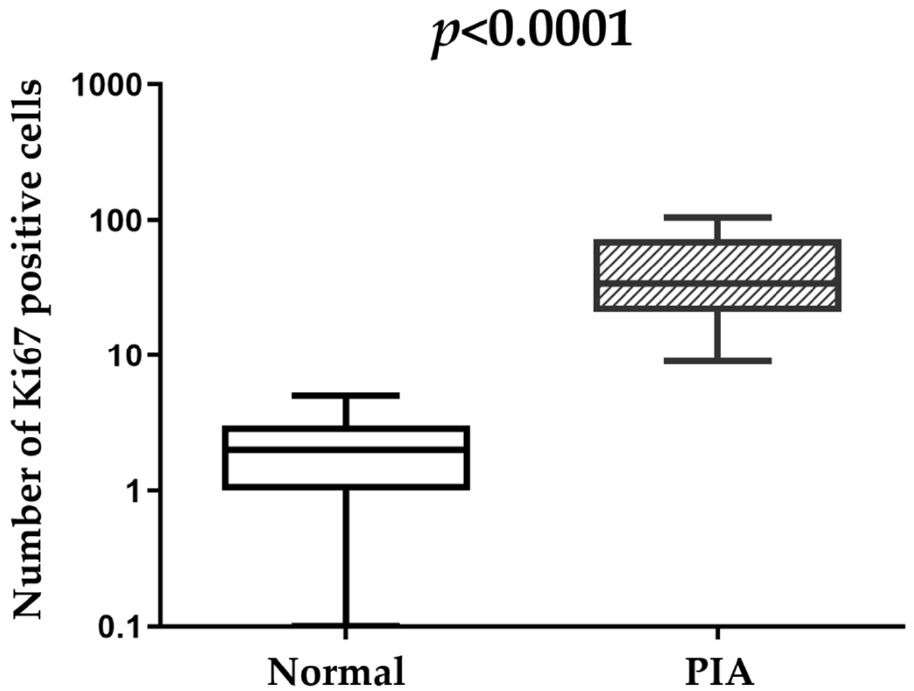
Figure 2. Ki67 protein expression in normal and proliferative inflammatory atrophy (PIA) samples. A high Ki67 index was observed in PIA compared to normal samples, indicating a high proliferative rate in PIA ( p < 0.0001).